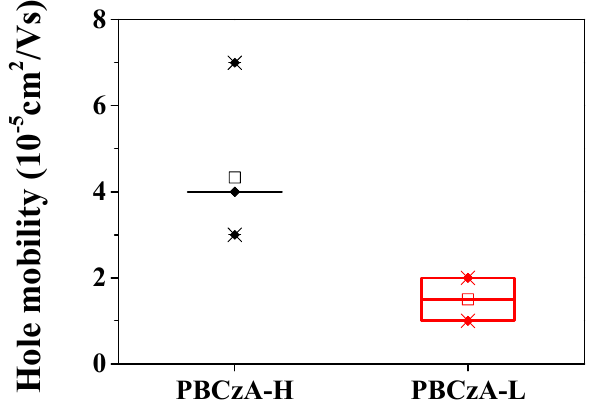
Figure 6. Hole mobilities of PBCzAs calculated using J – V data of additive-free hole-only devices. Symbols x, − , □ stand for minimum or maximum, 1% or 99% and averaged values, respectively. The bottom and upper sides of the square indicate lower and upper quartiles, respectively.